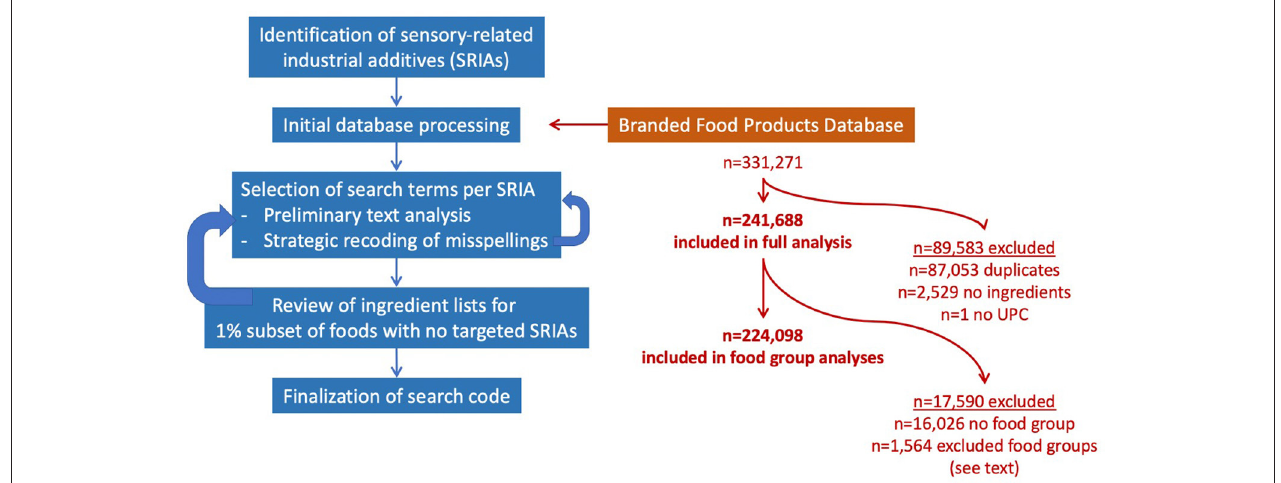
FIGURE 1 | Graphical scheme illustrating study approach and database used. Initial identification of sensory-related industrial additives (SRIAs) was compiled from US Food and Drug Administration (12), International Food Information Council (14), and SugarScience (20) websites. Following preliminary editing of the Branded Food Products Database, an iterative process was used to identify search terms for each SRIA, which included a preliminary text analysis and selective recoding of misspellings. Ingredient lists for a 1% subset of foods with no SRIAs were reviewed for errors or omissions, and search terms were revised. The process was repeated until no further modifications were deemed necessary. Also shown are numbers of BFPD food items included in